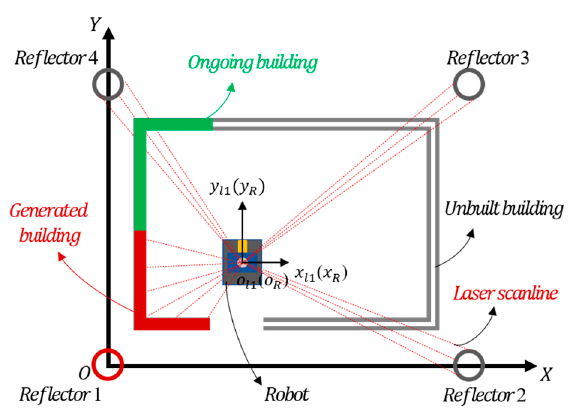
Figure 5. Robust localization model based on artificial reflectors and ongoing buildings.